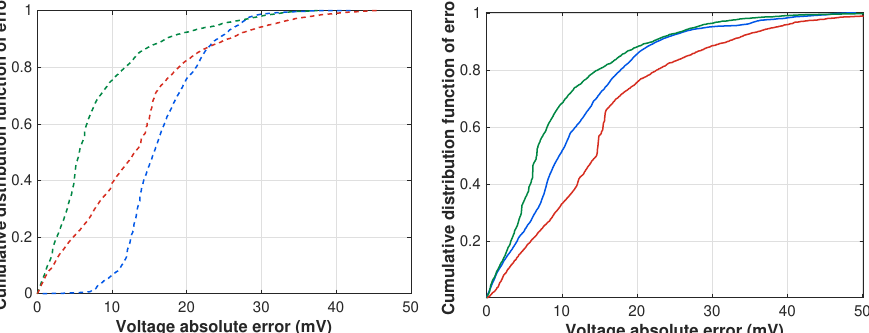
Figure 13. Influence of temperature over RC model (( left ), dashed line) and CPE model (( right ), solid line) accuracy. Blue lines are at 0 °C, green lines at 25 °C and red lines at 40 °C.